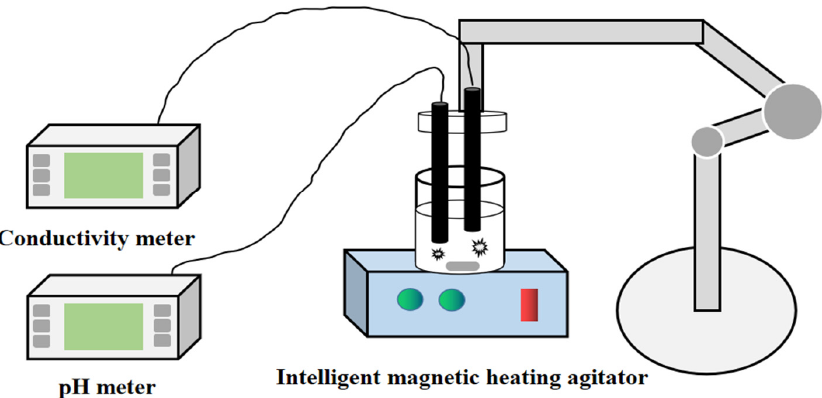
Figure 1. Schematic diagram of the experimental apparatus, the solution was stirred at constant temperature by a constant temperature heating magnetic stirrer at 35 °C and 250 r/min for 120 min.